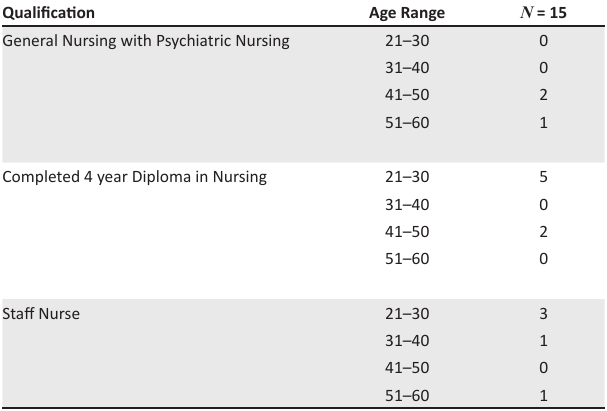
TABLE 3: Demographic profile of nurses who took part in the interviews ( N = 15).